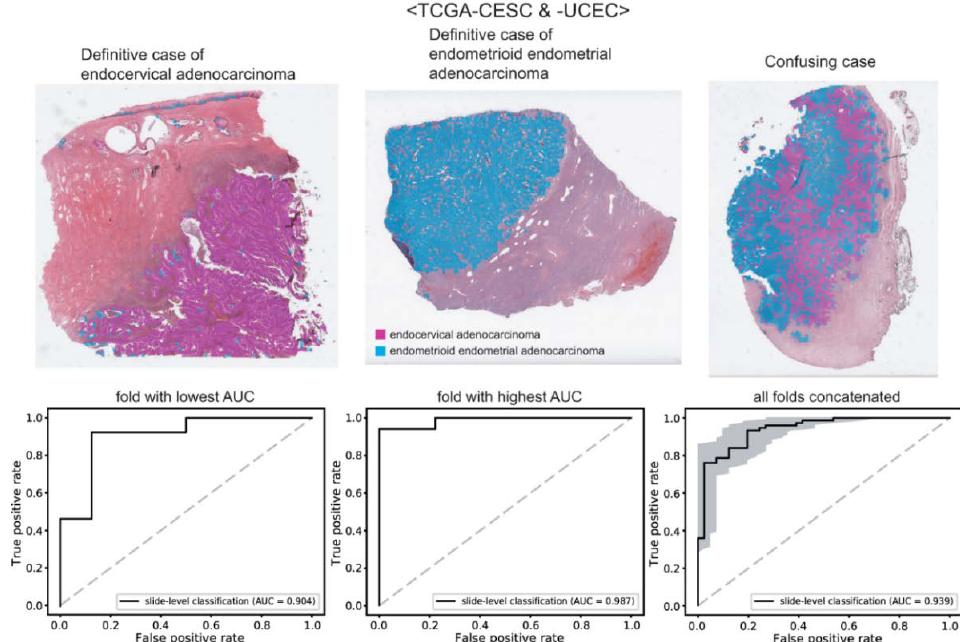
Figure 6. Classification results for the origin of adenocarcinomas. Upper panels: the representative whole slide images of clear endocervical adenocarcinoma, clear endometrioid endometrial adenocarcinoma, and confusing case with mixed classification results. Lower panels: the receiver operating characteristic curves of slide-level classification results for folds with the lowest and highest area under the curve (AUC) and concatenated results of all 5-folds.